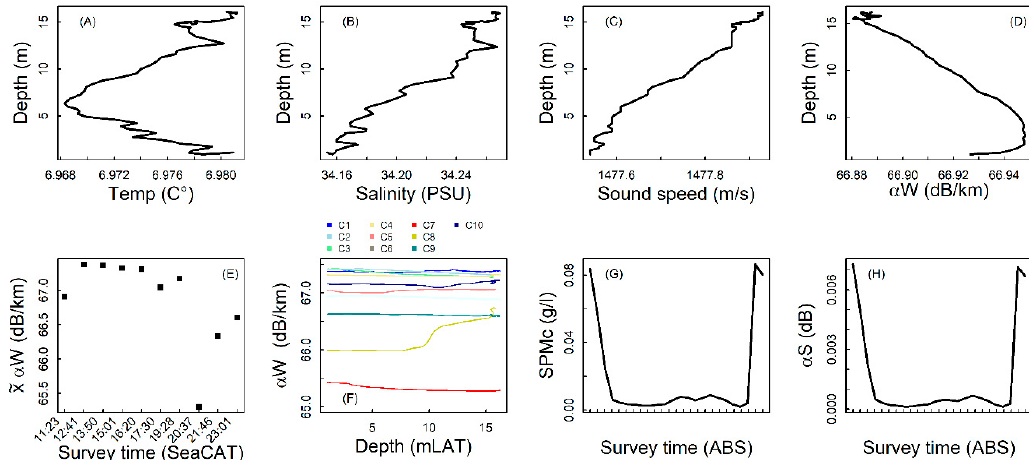
Figure 11. Temperature ( A ), salinity ( B ), sound speed ( C ), and absorption coefficient (at 300 kHz) due to seawater ( D ) over depth for one CTD downcast (~15 m). Vertically averaged ( E ) and full profiles ( F ) of α w coefficients. ( G ) Averaged SPMc (g/L) for the 1 m profile above seabed as obtained by the ABS sensor installed on the benthic lander. ( H ) Absorption due to suspended sediment ( α s ) for the 1-m profile above seabed computed as a function of vertically averaged SPMc in G and vertically averaged grain size (shown in Figure 7G).